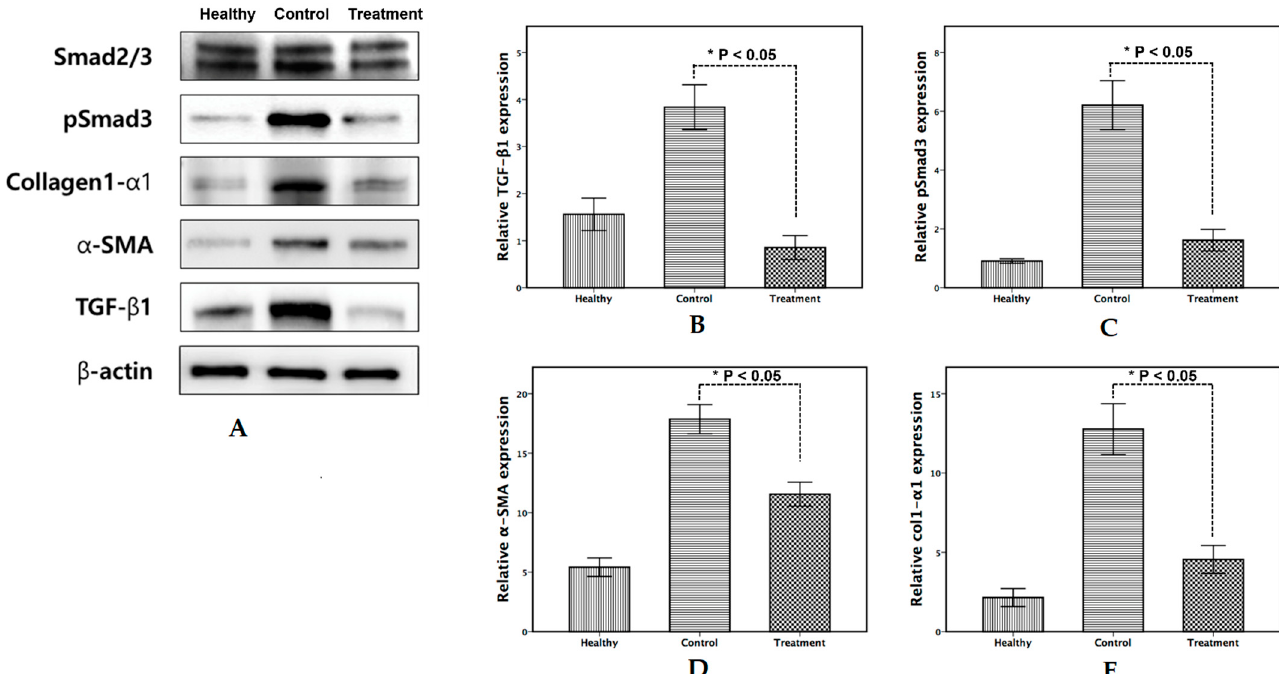
Figure 3. Representative Western blotting results ( A ). Quantitative expression ratio of TGF- β 1, pSmad3, and α -SMA were significantly decreased in the treatment group compared with the control group (( B – E ), respectively) ( p = 0.001).